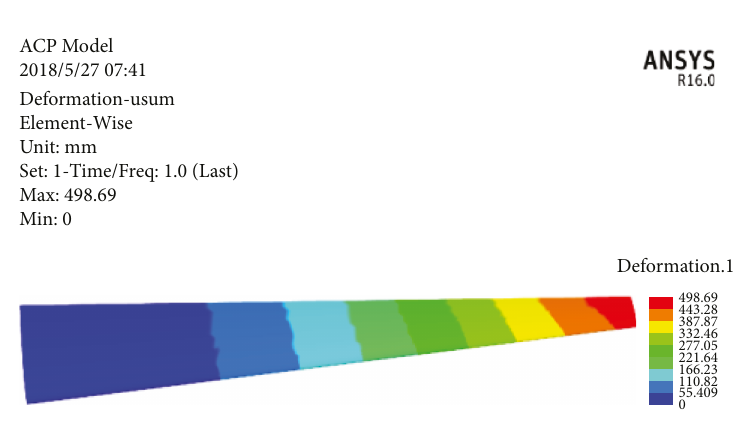
Figure 44: Deformation cloud diagram with the layer ratio being